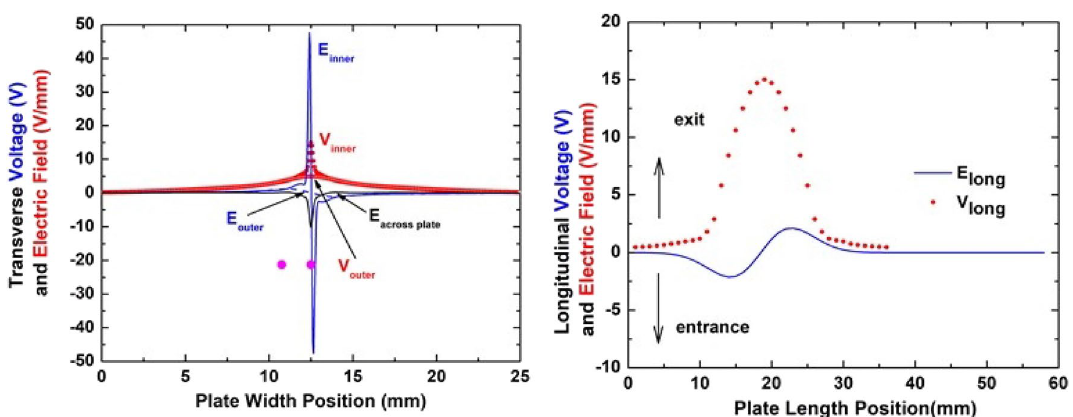
Figure 2. SIMION predicted voltages (red symbols) and electric fields (blue lines) transverse and along the beam direction due to a charge patch on the lower glass plate in the upper portion of Fig. 1. Filled symbols, indicated by V inner , and solid lines are along the inner surface; open, indicated by V outer , and dashed lines are along the outer surface; the black curve is the internal field of the glass plate pointing outwards from the inner to outer surface. For the transverse (longitudinal) fields, + , − indicates field direction toward the 25, 0 mm side (toward the exit, entrance ends). All examples are for a 15 V maximum potential of the patch voltage. The solid magenta circles illustrate the magnitude of the fields at the location of the two bypass